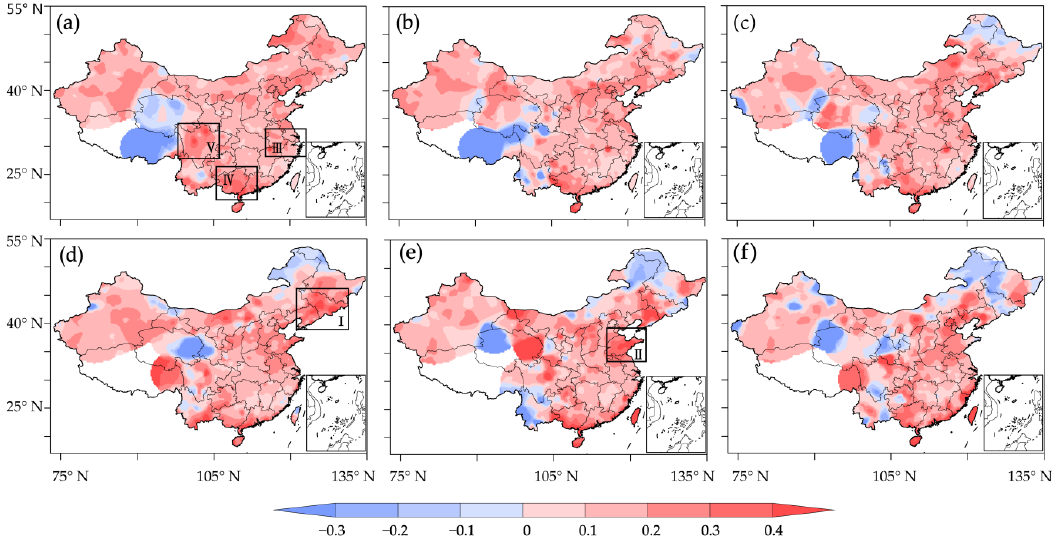
Figure 5. Distribution of change rate of dominant results with the increase of threshold. ( a ) 27 − 28 °C, ( b ) 28 − 29 °C, ( c ) 29 − 30 °C, ( d ) 30 − 31 °C, ( e ) 31 − 32 °C, ( f ) 32 − 33 °C. Boxes denote five regions.